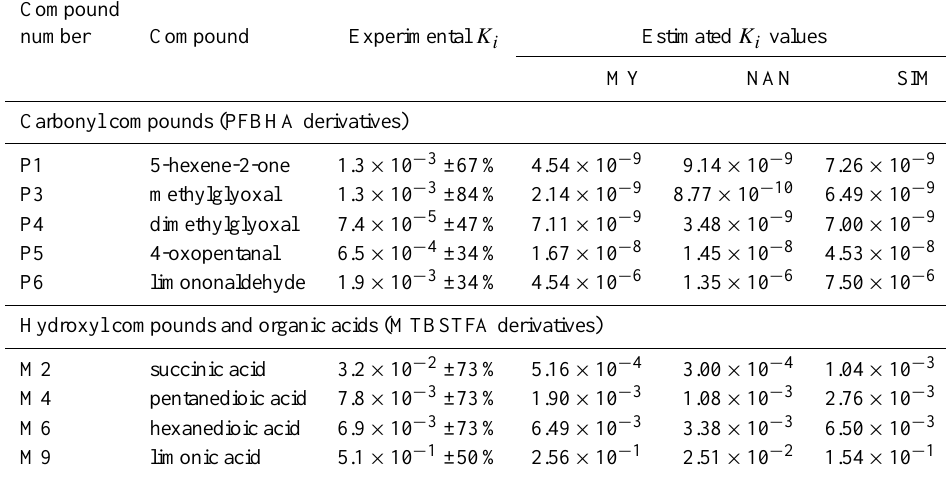
Table 9. Experimental partitioning coefficient K i (m 3 µg − 1 ) compared with K i values (m 3 µg − 1 ) estimated from theoretical saturation vapour pressures ( P o ) calculated from 3 group contribution methods at 298K. K i calculation assumes a temperature of 300K, a mean L ,i MW om of 142gmol − 1 and an activity coefficient γ i of 1.27. MY: Myrdal and Yalkowsky, 1997. NAN: Nannoolal et al., 2008. SIM: Pankow and Asher,